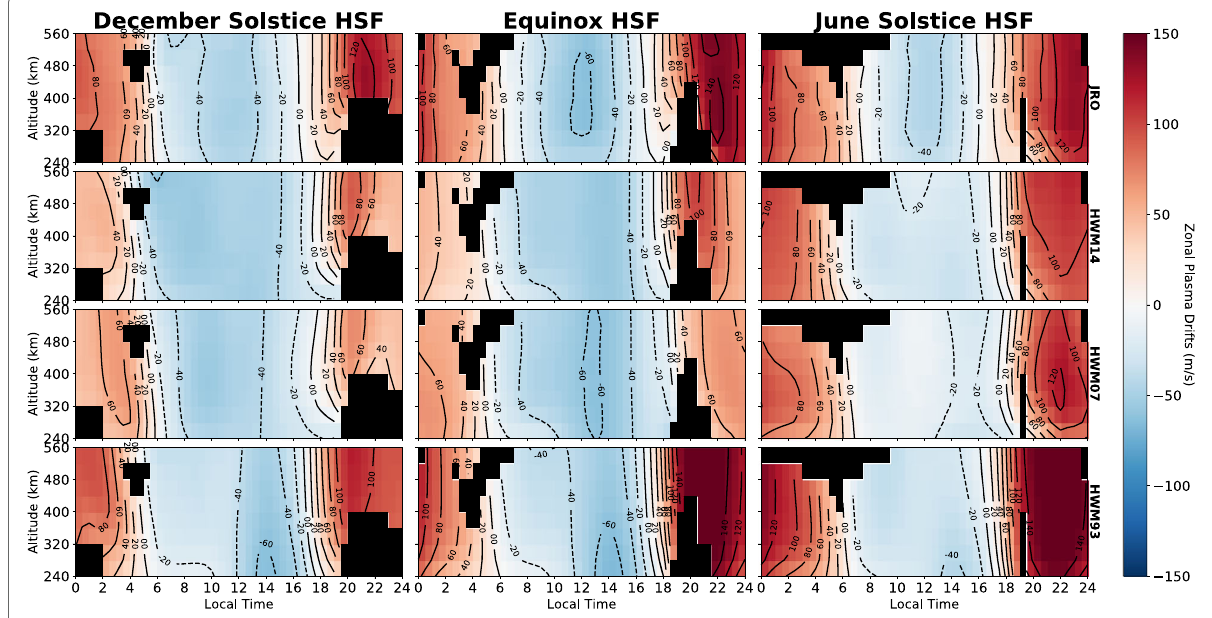
Fig. 3 Local time versus height color plots for the Jicamarca climatological zonal drifts and the model zonal drifts using HWM14, HWM07, and HWM93, during HSF